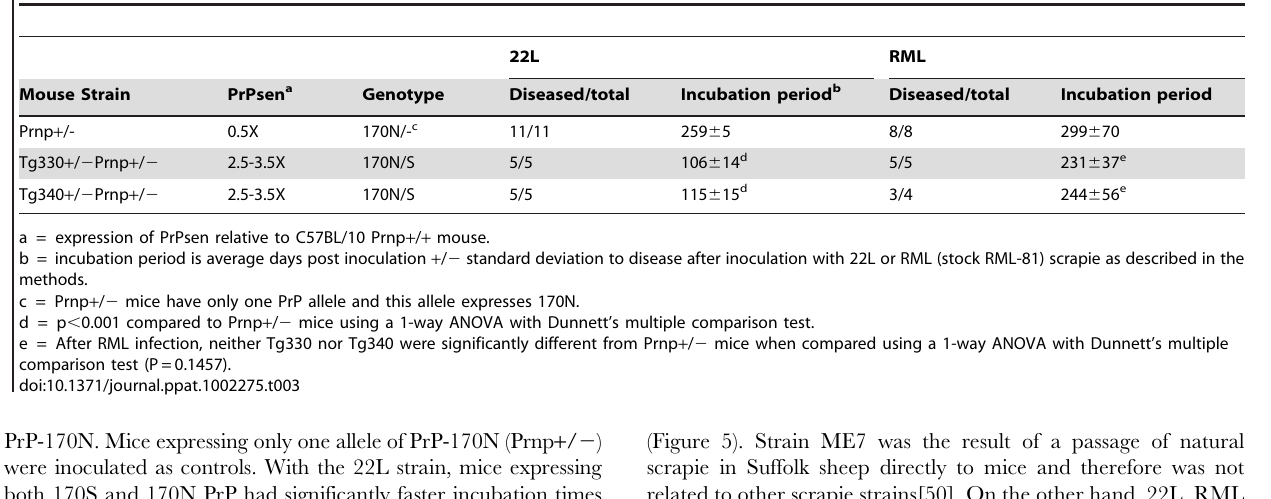
Table 3. Effect of coexpression of 170N and 170S PrPsen on prion disease after inoculation with scrapie strains 22L or